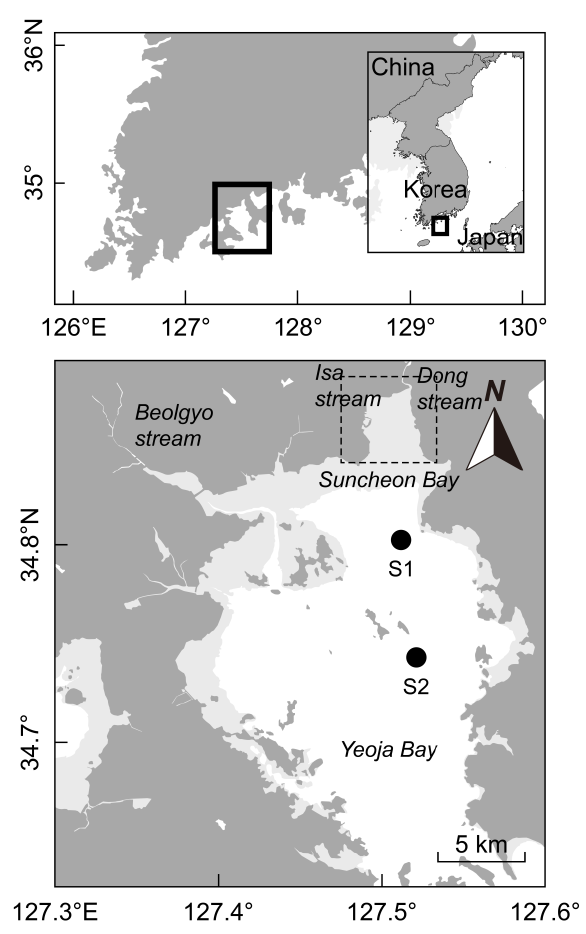
Figure 1. Map showing the study area and the sampling stations in Yeoja Bay. The gray-shaded area indicates intertidal zones. The black circles indicate the subtidal sample stations used for the collection of phytoplankton, potential food sources, and ark clams.